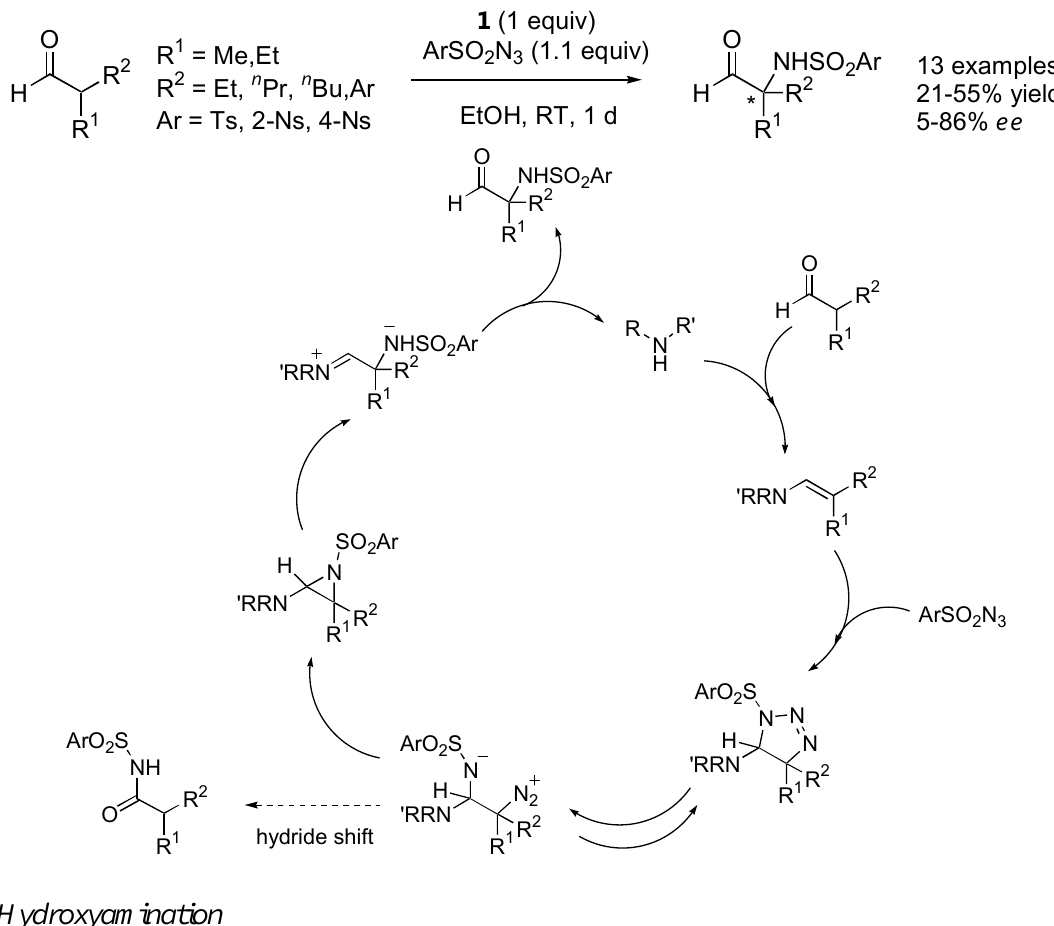
Figure 15.  -Sulfamidation of  -branched aldehydes catalyzed by L -proline ( 1 )